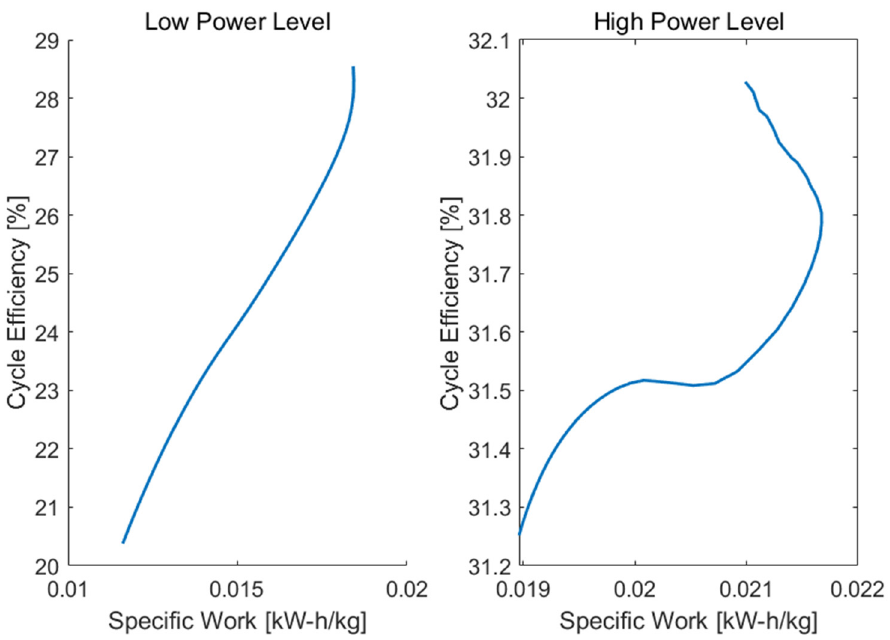
Figure 27. Cycle Efficiency along the cycle Specific Work at low and high power